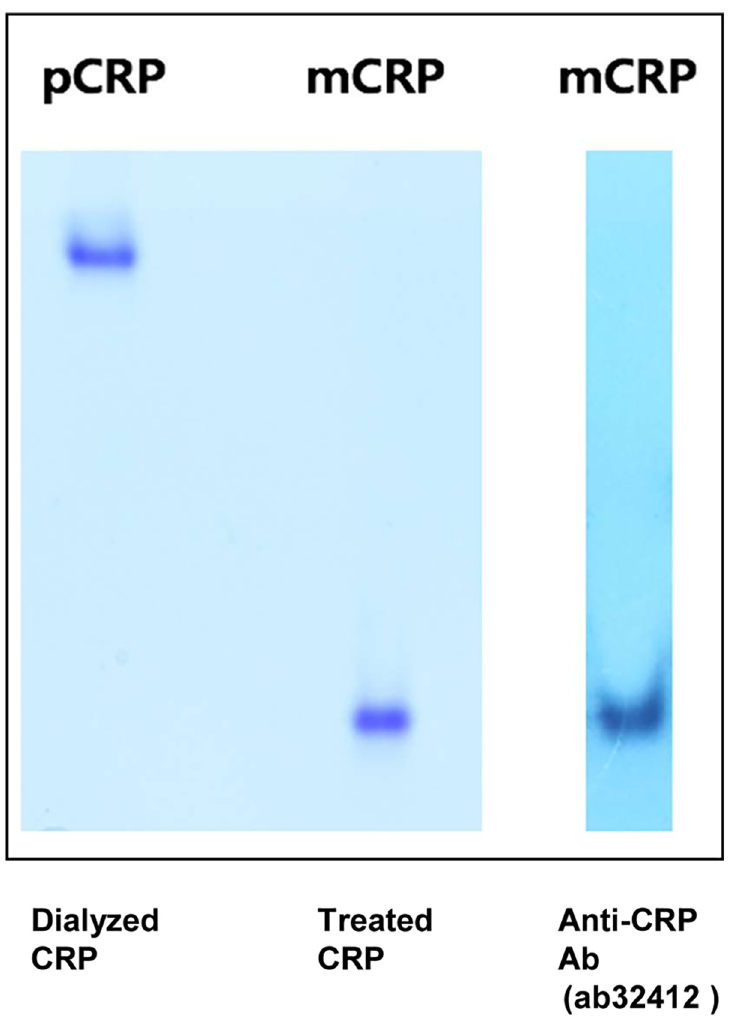
Fig 1. Western blot of dialyzed CRP and treated CRP with urea and EDTA. The dialyzed CRP appeared at much higher sizes than the treated CRP did, suggesting pentameric CRP (pCRP) and monomeric CRP (mCRP), respectively. Western blotting showed that the mCRP was detected with the anti-CRP antibody (ab32412). pCRP, but no mCRP, was found in infused human CRP.